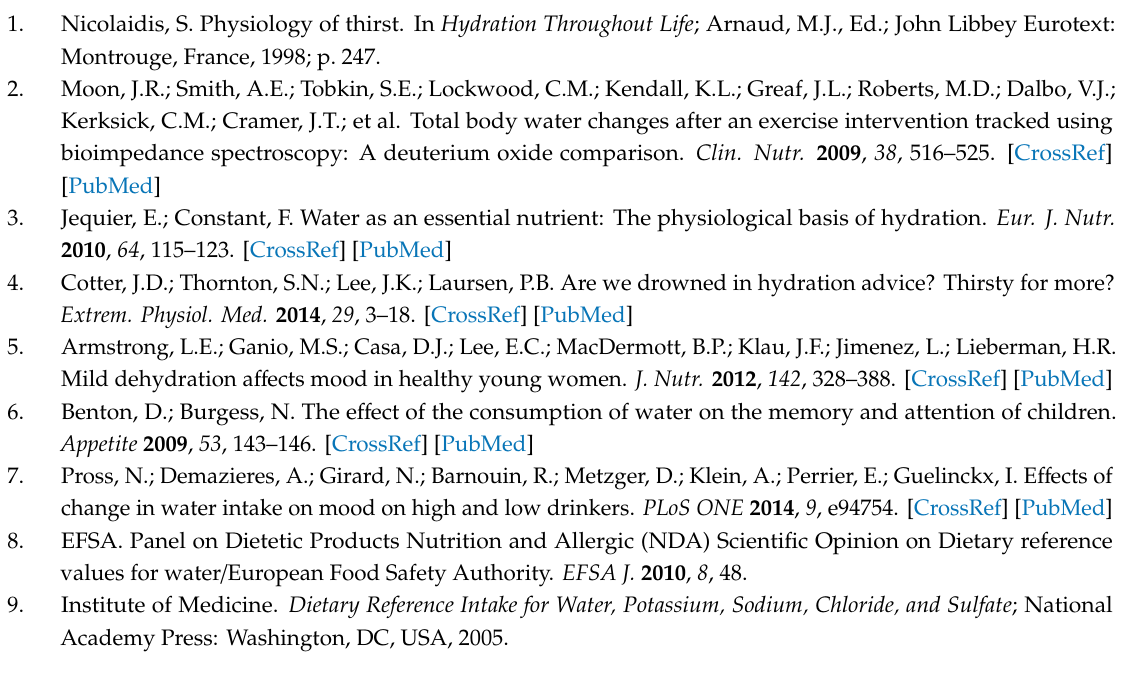
Figure S1: Questionnaire diary of fluid and food intake, Table S1: Changes in each parameter due to water supplementation. Data are given as mean (SD). * Paired t -test adjusted by Bonferroni method was performed for intragroup comparisons from Week 0. * p < 0.05, ** p < 0.001, n = 27 (control group) or n = 28 (intervention group); a: p value indicated the di ff erence between the groups for the change from Week 0 to Week 12. Two-way analysis of variance was performed, Table S2: Intestinal bacteria showing significant changes within and between groups due to water supplementation. Intestinal bacteria identified at the genus level from phylum, and intestinal bacteria identified by homology search of OTU representative sequence in DDBJ 16S database. Between Week 0 to Week 12, increase ( ↑ ), decrease ( ↓ ) and unchanged (—) have been